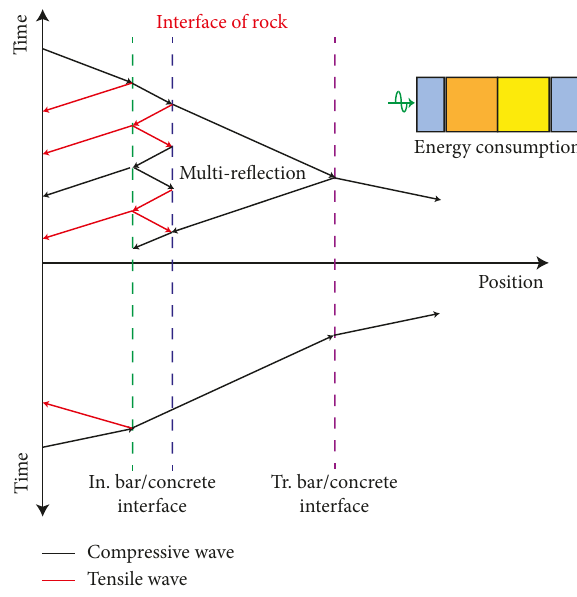
Figure 15: Diagram of stress wave propagation at the interface of composite (After Pothnis,